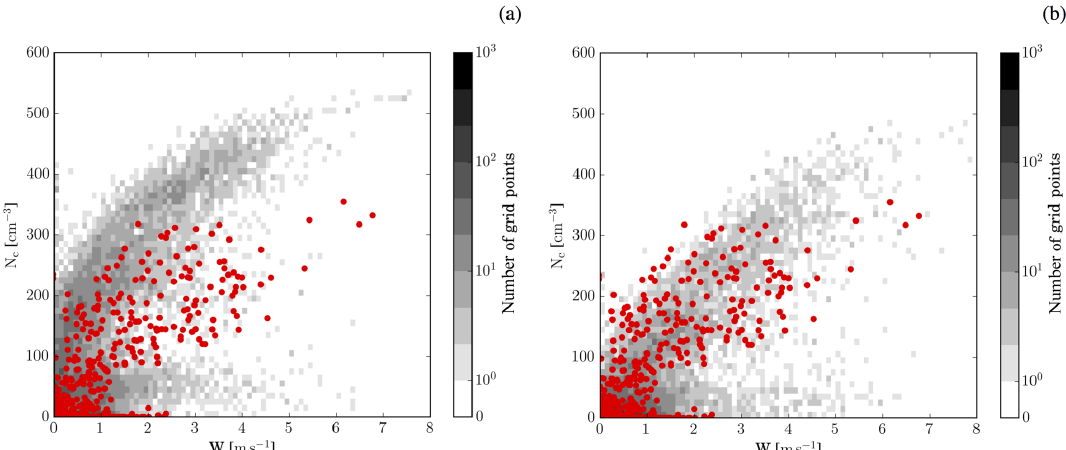
Figure 3. Cloud base cloud droplet number density as a function of vertical velocities from aircraft data (red symbols) and model data (grey shading). Panel (a) shows the simulation with passive aerosols and panel (b) the simulation with aerosol processing. The simulations in both panels use the standard-aerosol profile. Aircraft observations include data collected during low-level flight legs close to cloud base ( ¯ z = 1160 m, 12:00 to 12:50UTC). CDP measurements are used for the cloud droplet number concentrations and Airborne Integrated Meteorological Measurement System (AIMMS)-20 measurements for the vertical velocity. Cloud base cloud droplet number density and vertical velocity in the model is retrieved from the lowest model level with a cloud droplet mass larger than 1 mg kg − 1 from the entire domain between 12:00 and